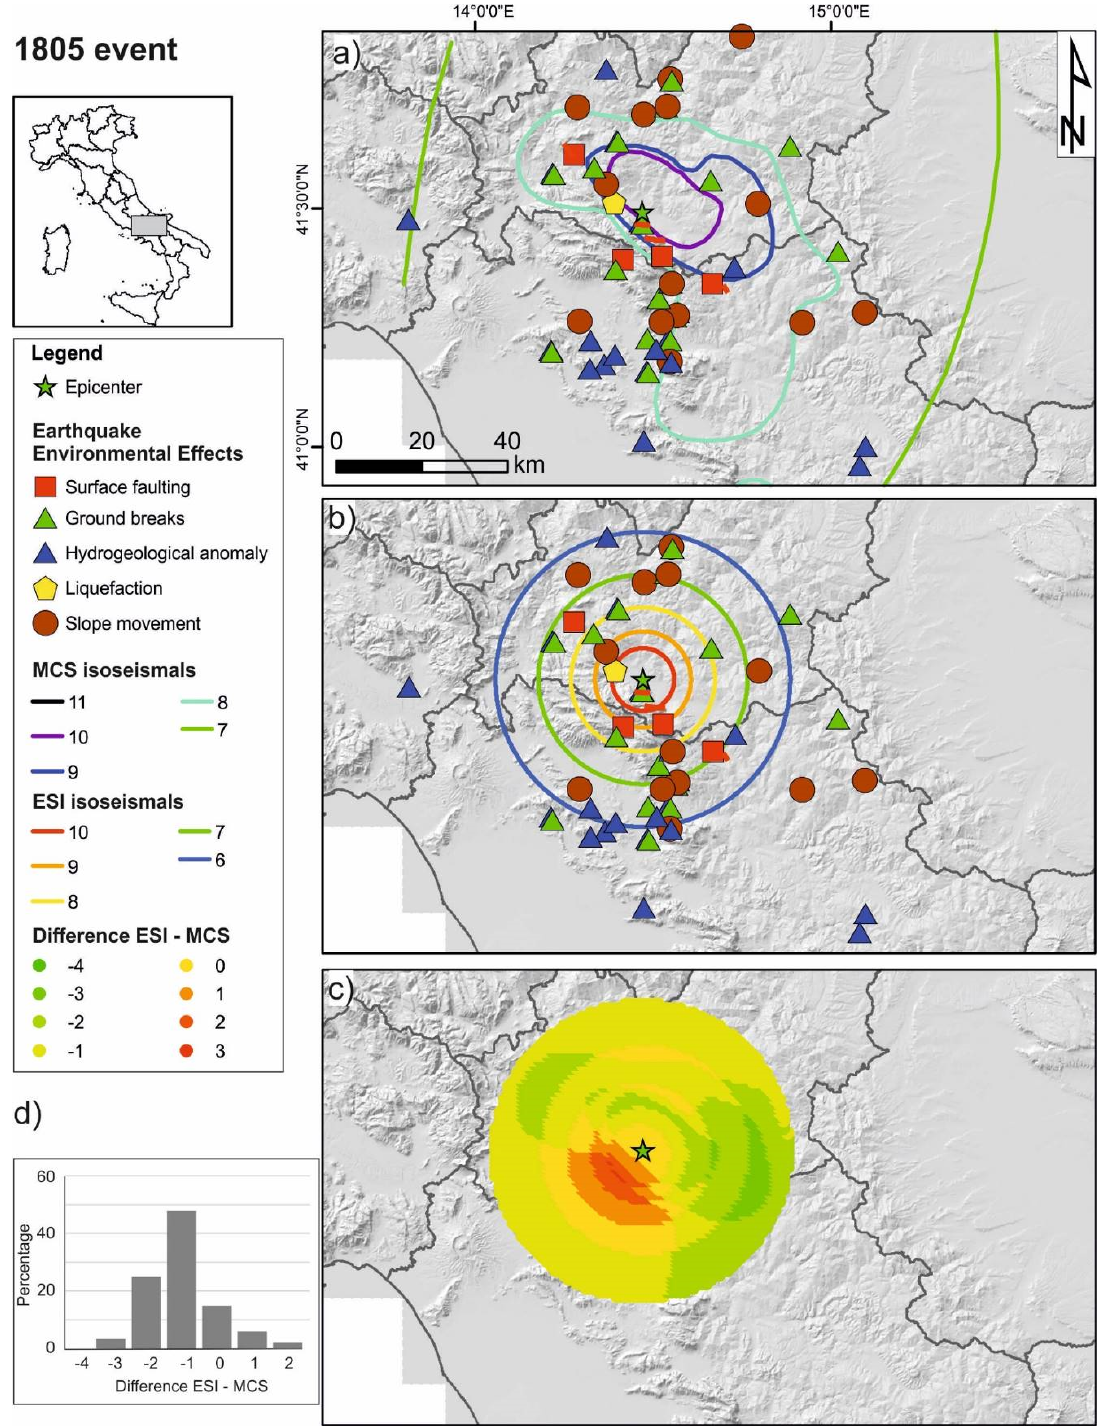
Figure 6. ( a ) map of EEEs and MCS isoseismals of the 1805 earthquake; ( b ) map of EEEs and ESI isoseismals derived from the intensity prediction equation (IPE); ( c ) map showing the difference between ESI and MCS intensities; ( d ) histogram of the ESI-MCS difference. Inset shows, in the grey rectangle, the study area in a larger map around Italy.